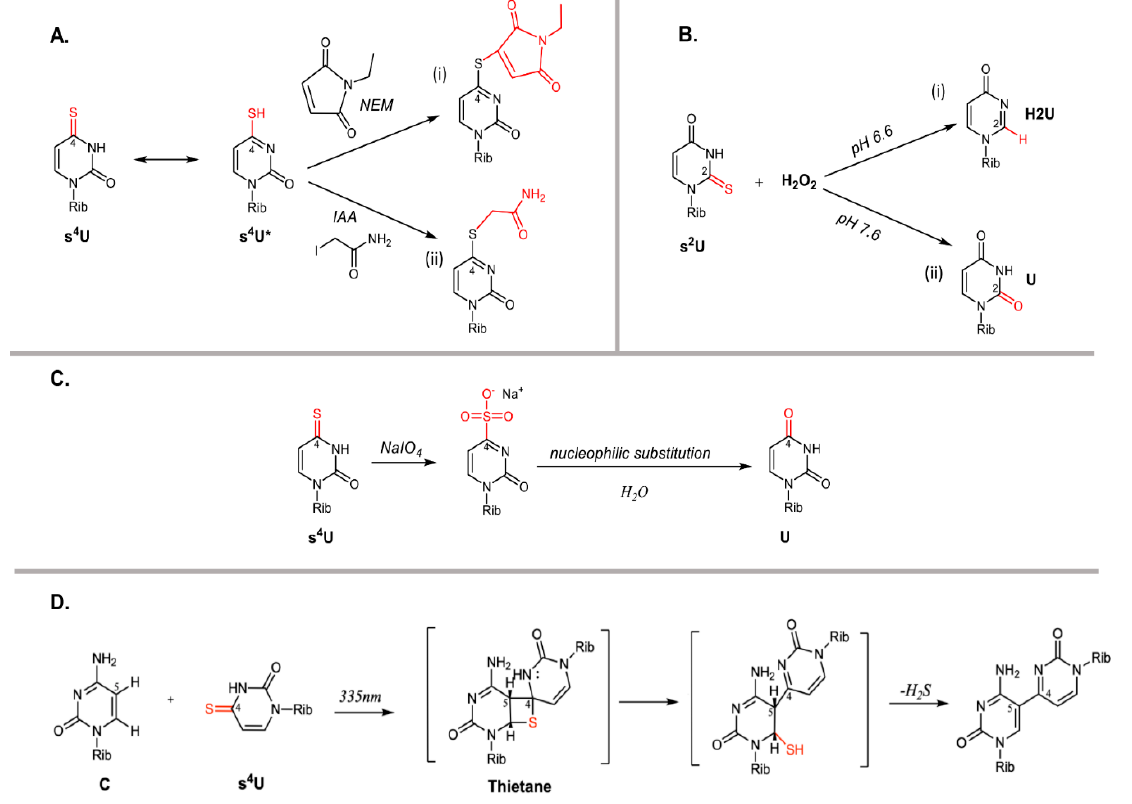
Figure 4. Direct reactions involving thiouridines. ( A ) Alkylation reactions of reactive thiols are shown through (i) thiol-Michael addition of s 4 U with N-methylmaleimide (NEM) [56] and (ii) nucleophilic substitution with iodoacetamide (IAA) [57]; ( B ) Oxidation of s 2 U with hydrogen peroxide yields the formation of (i) 4-pyrimidinone under mildly acidic conditions and (ii) uridine under mildly basic conditions [53]; ( C ) Oxidation of s 4 U with sodium periodate (NaIO 4 ) leads to the formation of U [49]; ( D ) UV radiation promotes the radical-catalyzed cycloaddition reaction of s 4 U and C [52].